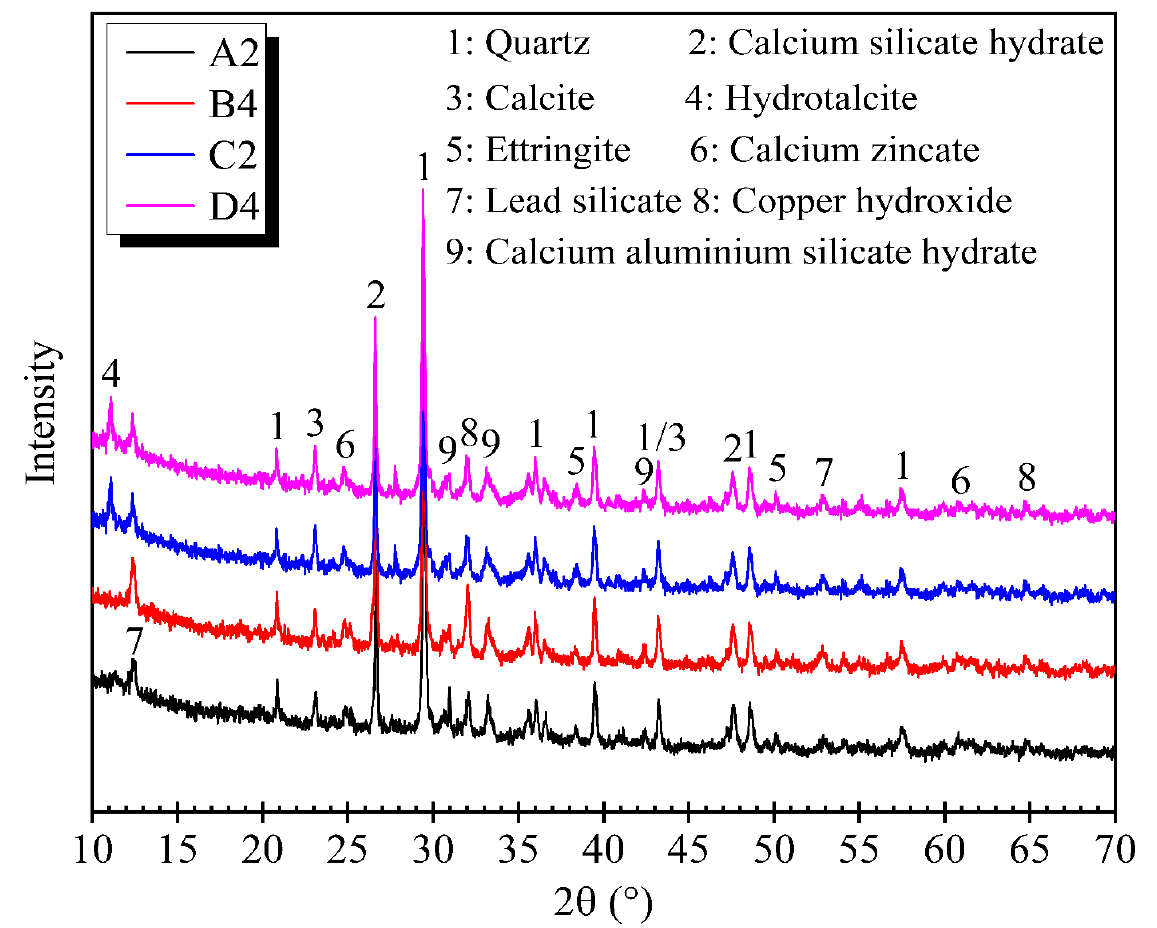
Figure 6. XRD diffractograms of CMS samples treated by OPC and CG after 28 days of curing.